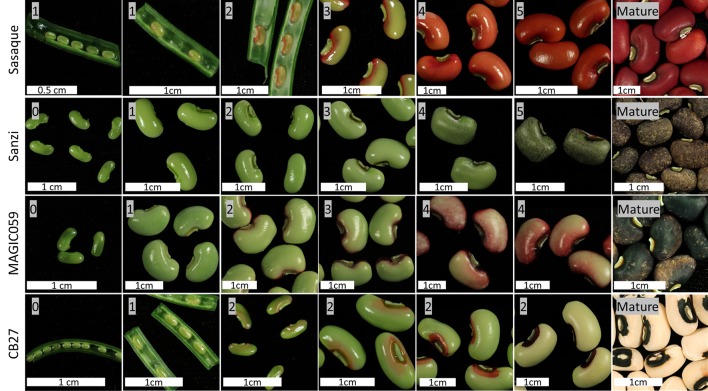
Seed coat color development. Images showing the development the seed and the spread of pigmentation.